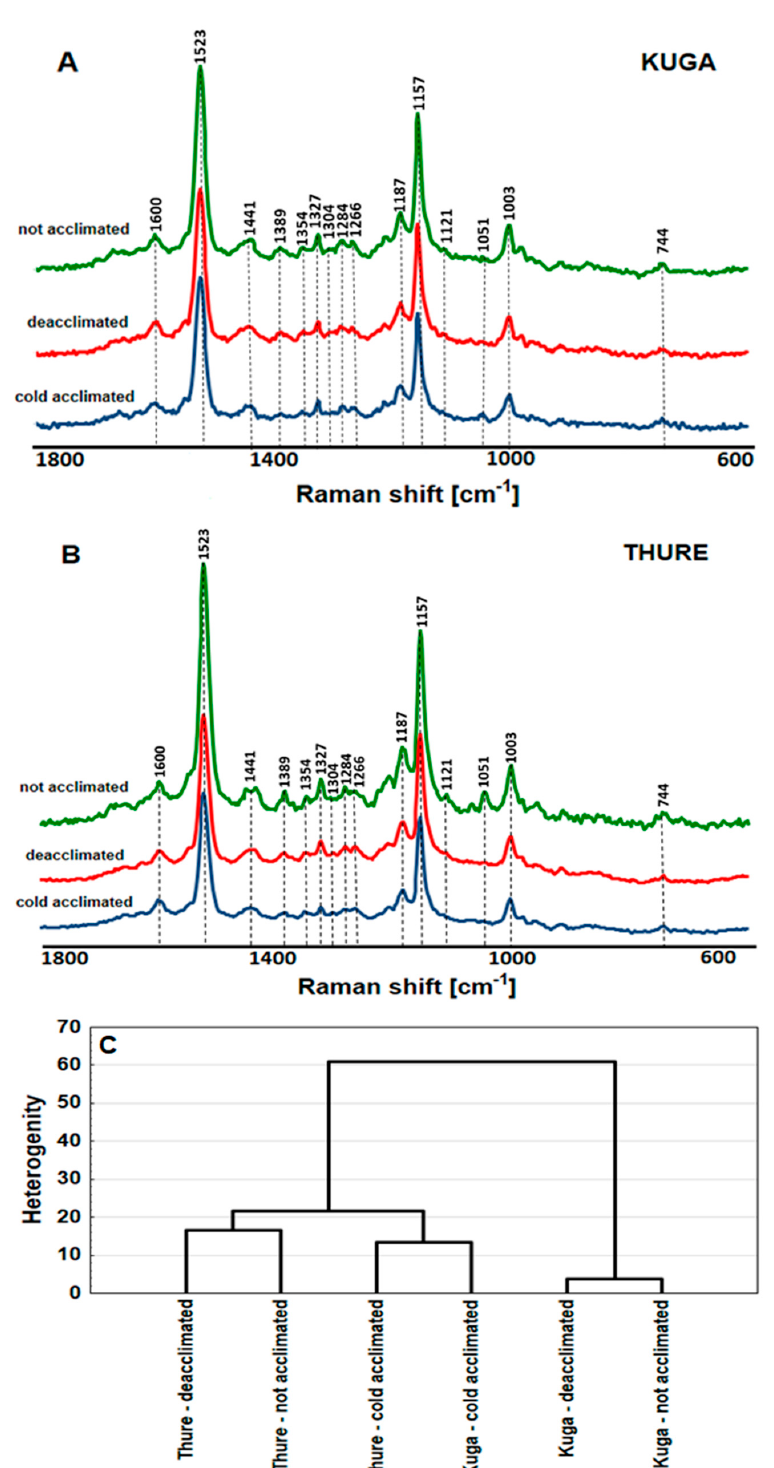
Figure 7. FT-Raman spectra of the leaves of the not acclimated (green line), cold-acclimated (blue line), and deacclimated (red line) oilseed rape cv. Kuga ( A ) and cv. Thure cultivars ( B ). Cluster analysis of the FT-Raman spectra of the oilseed rape cv. Kuga cv. Thure cultivars ( C ).